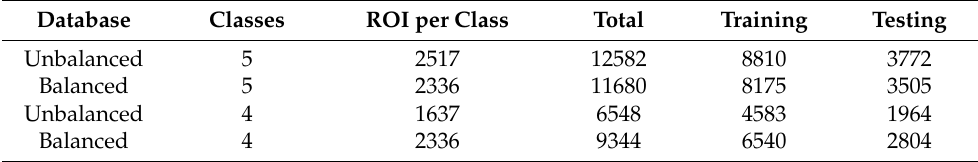
Table 3. ROIs used for balanced and unbalanced